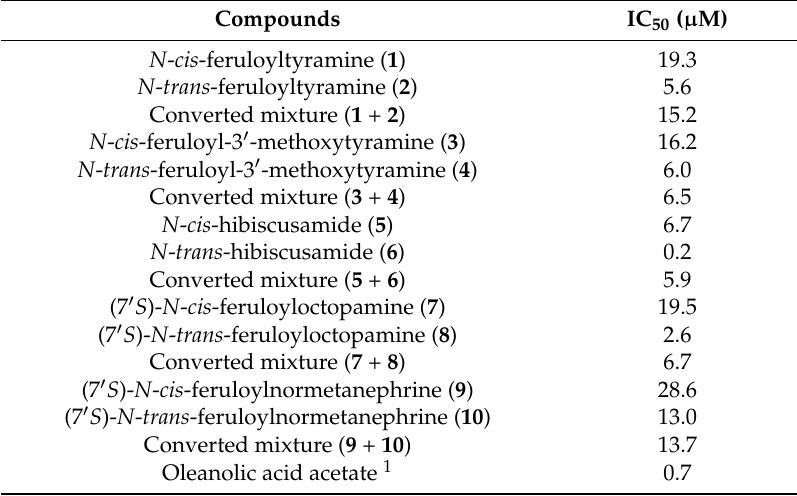
Table 2. IC 50 values of compounds 1 – 10 for the inhibition of the induction of STAT3 by